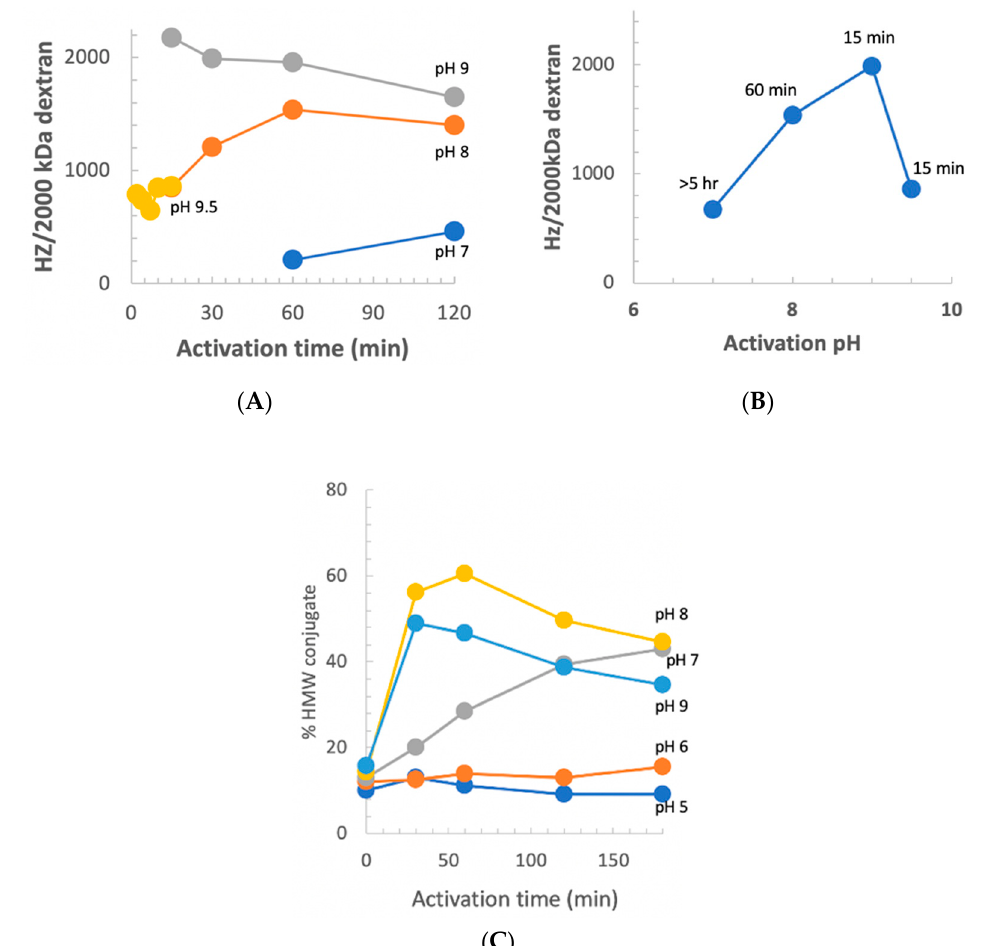
Figure 8 . CDAP activation of dextran at pH 5–9.5 as a function of time at 0 °C. ( A ) ADH-derivatized dextran. ADH was reacted with 2000 kDa dextran activated at pH 7–9.5 using 0.5 mg CDAP/mg dextran with DMAP and NaOH to maintain the reaction pH. ( B ) Peak level of derivatization vs. activation pH. Peak activation time is indicated above each point. ( C ) TNP-BSA-conjugated dextran. Dextran was activated using 0.5 mg CDAP/mg dextran at pH 5–9 using buffers to maintain the pH. The activated dextran was reacted with TNP 1 -BSA overnight at pH 9 and then analyzed by SEC HPLC. The level of dextran activation was determined from the % of high molecular weight protein. 0.1 M buffers: pH 5 sodium acetate, pH 6 MES, pH 7 and 8 HEPES and pH 9 sodium borate. At time 0, about 15% of the BSA was conjugated.